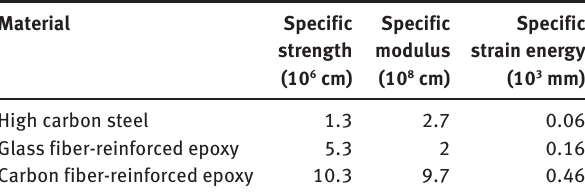
Table 1: Comparison of the material properties required for leaf springs between high carbon steel and fiber-reinforced polymer composites [1,